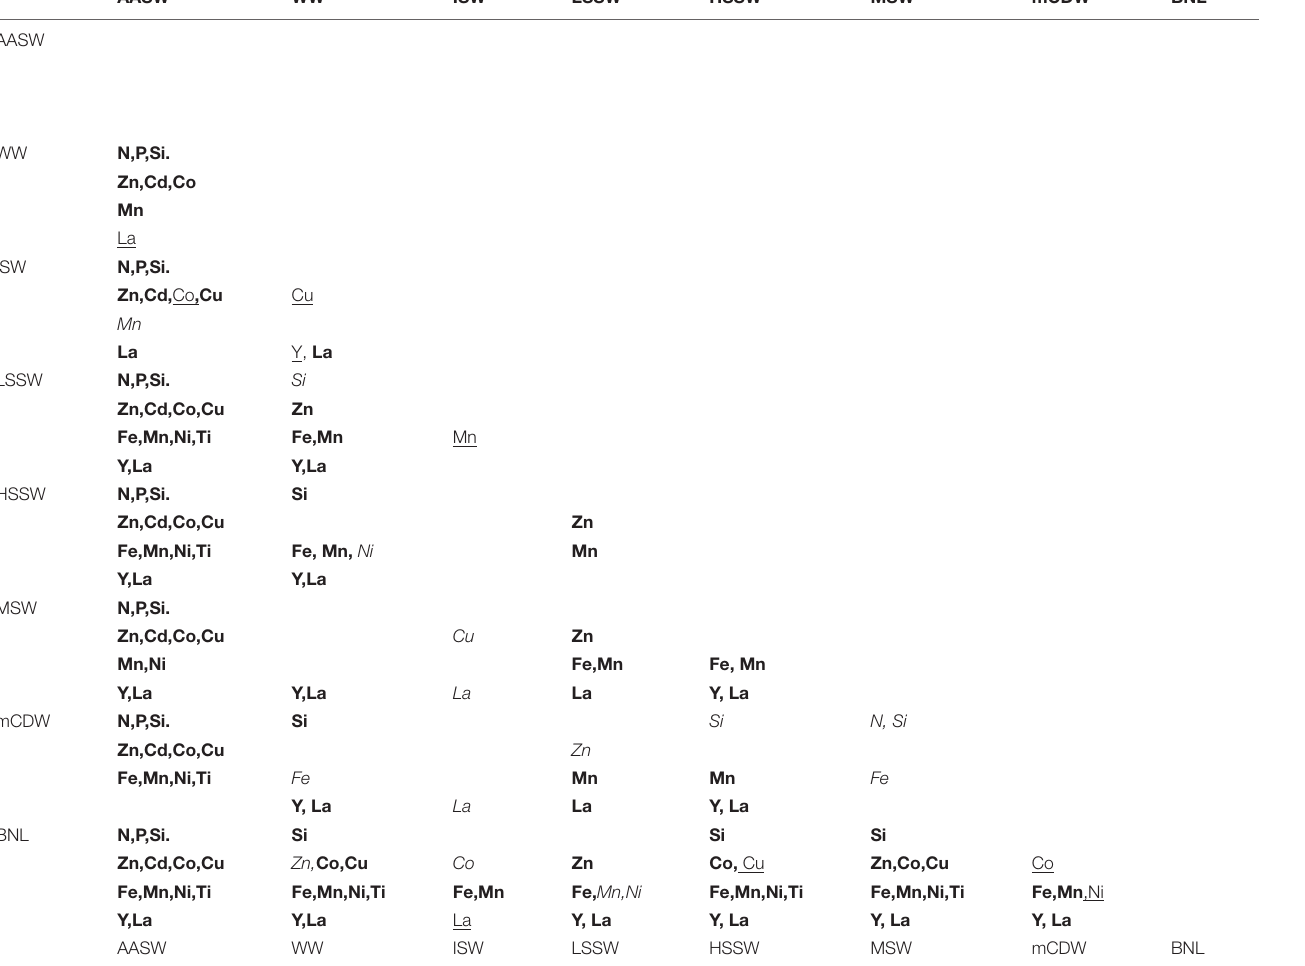
TABLE 3 | Correlation significance levels of differences of macro-nutrients and dissolved metals between the water masses. AASW WW ISW LSSW HSSW MSW mCDW